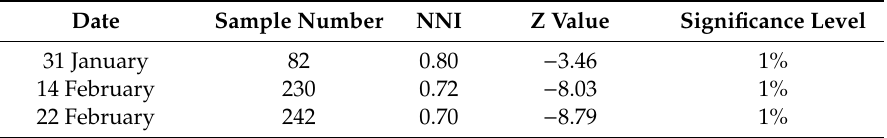
Table 1. NNI (nearest neighbor index) of epidemic site